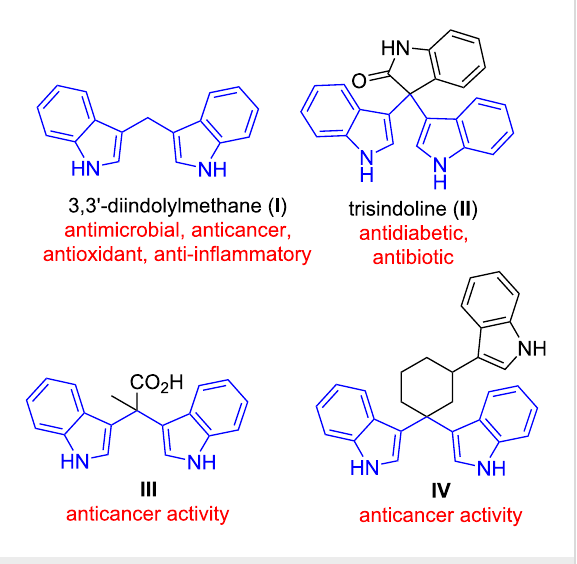
Figure 1: Diindolylmethanes and reported biological activities.